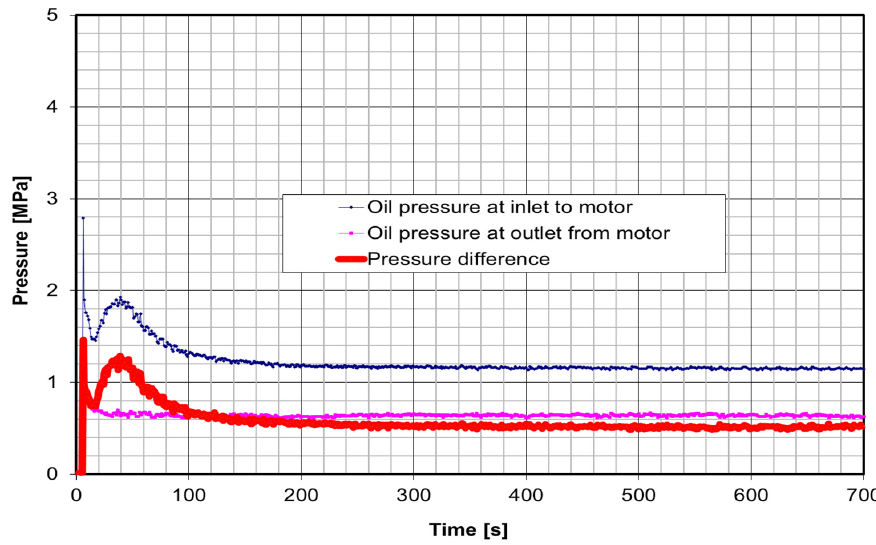
Figure 16. Characteristics of the oil pressure at the inlet and the outlet of the motor and the pressure difference as a function of time (ambient temperature (motor) − 4 °C, oil temperature 54 °C, rotational speed in steady-state conditions 185 rpm).